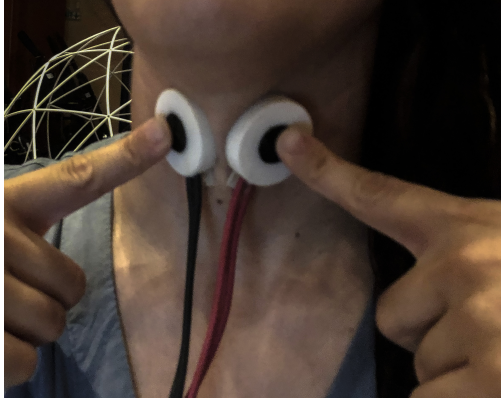
Figure 2. Participant displaying EGG electrode placement and